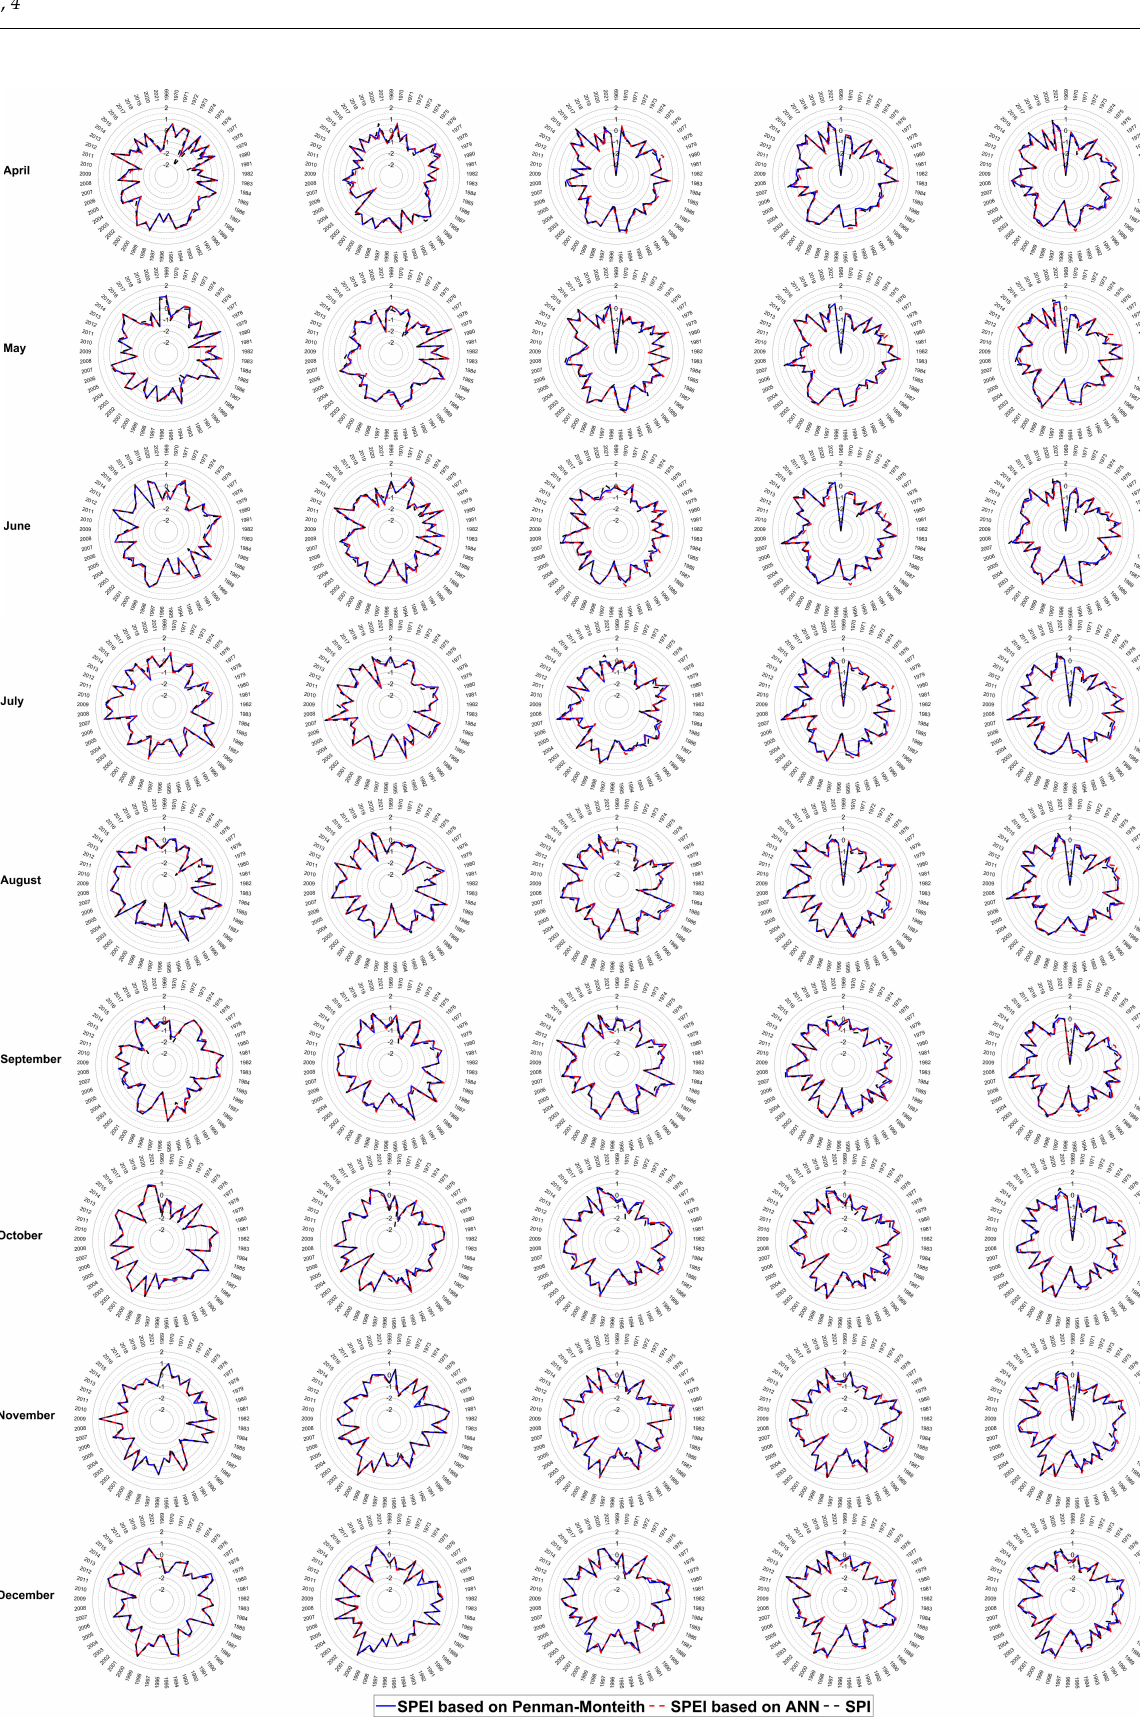
Figure 5. Comparison of SPI and SPEI using PET of Penman–Monteith and